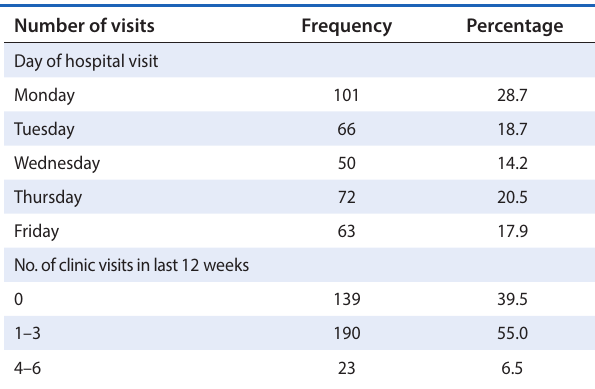
Table 3: Characteristics of subjects’ hospital visits Number of visits